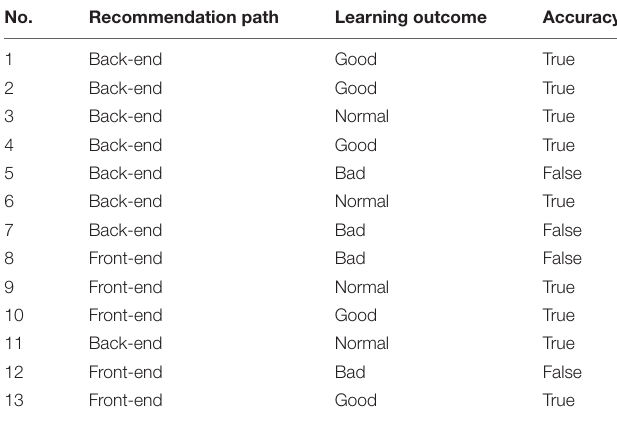
TABLE 1 | Learning path recommendation